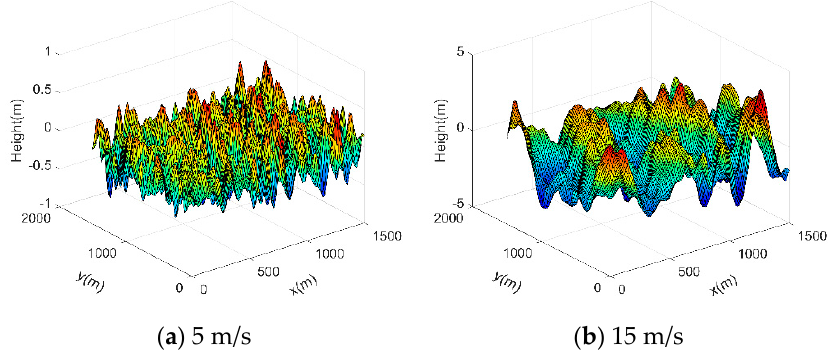
Figure 4. 3-D random sea surface with a wind speed of 5 m/s and 15 m/s.